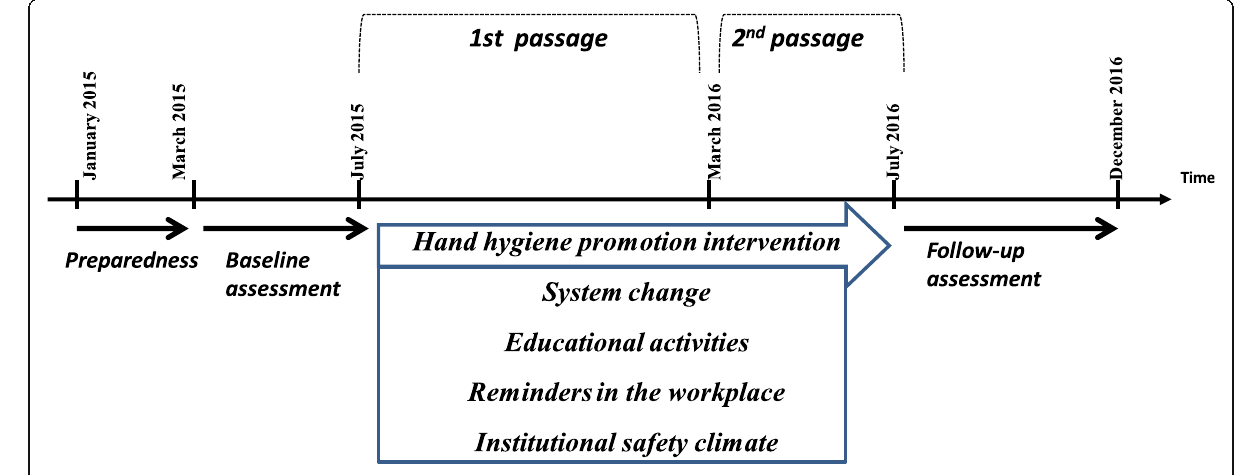
Fig. 1 The study design of the interventional study at the University Hospital Sahloul, Sousse, Tunisia